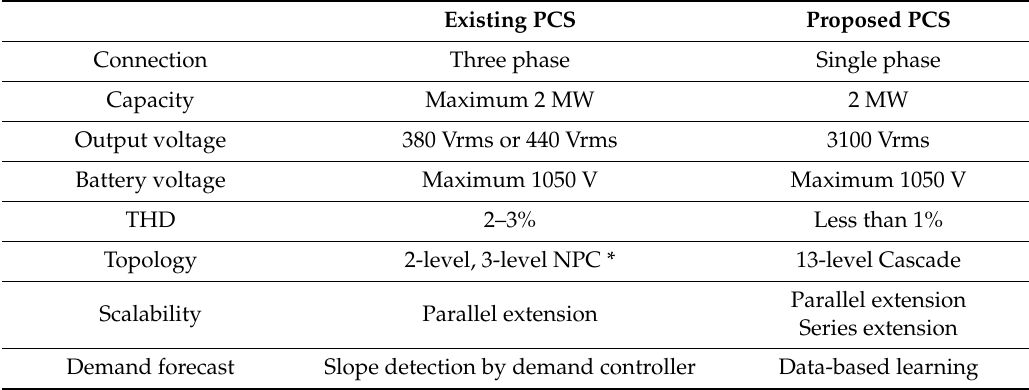
Table 2. Comparison of Specification between the Proposed PCS and the Existing